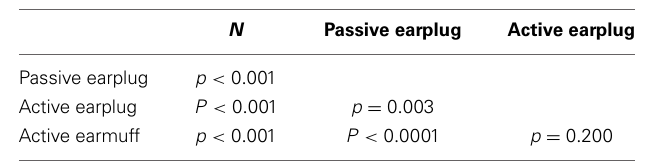
Table 4 | Results of pairwise comparisons between the different test conditions for different types of HPDs for up-down confusions.